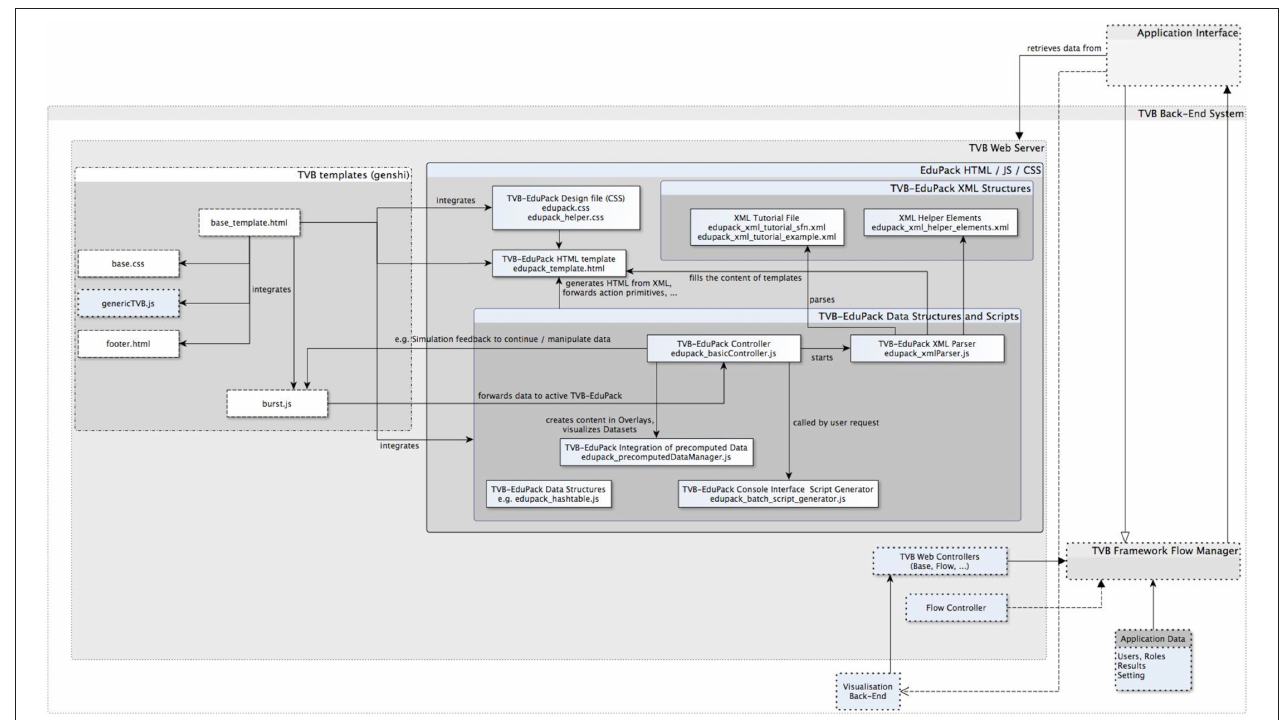
FIGURE 5 | Excerpt of TVB-framework component diagram with newly integrated EduPack modules and modified TVB modules.